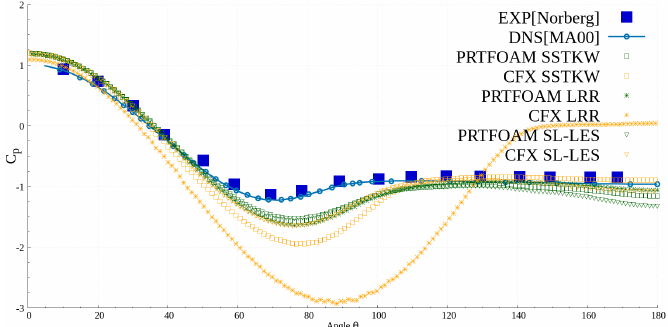
Figure 8. The pressure coefficient from 0 to 180 degrees of the upper half circle. Because the CFX LRR model cannot fully simulate vortex shedding, it has a large deviation from other models. Compared with other models except the CFX LRR model, the CFX SSTKW model is smaller at the minimum value of the pressure